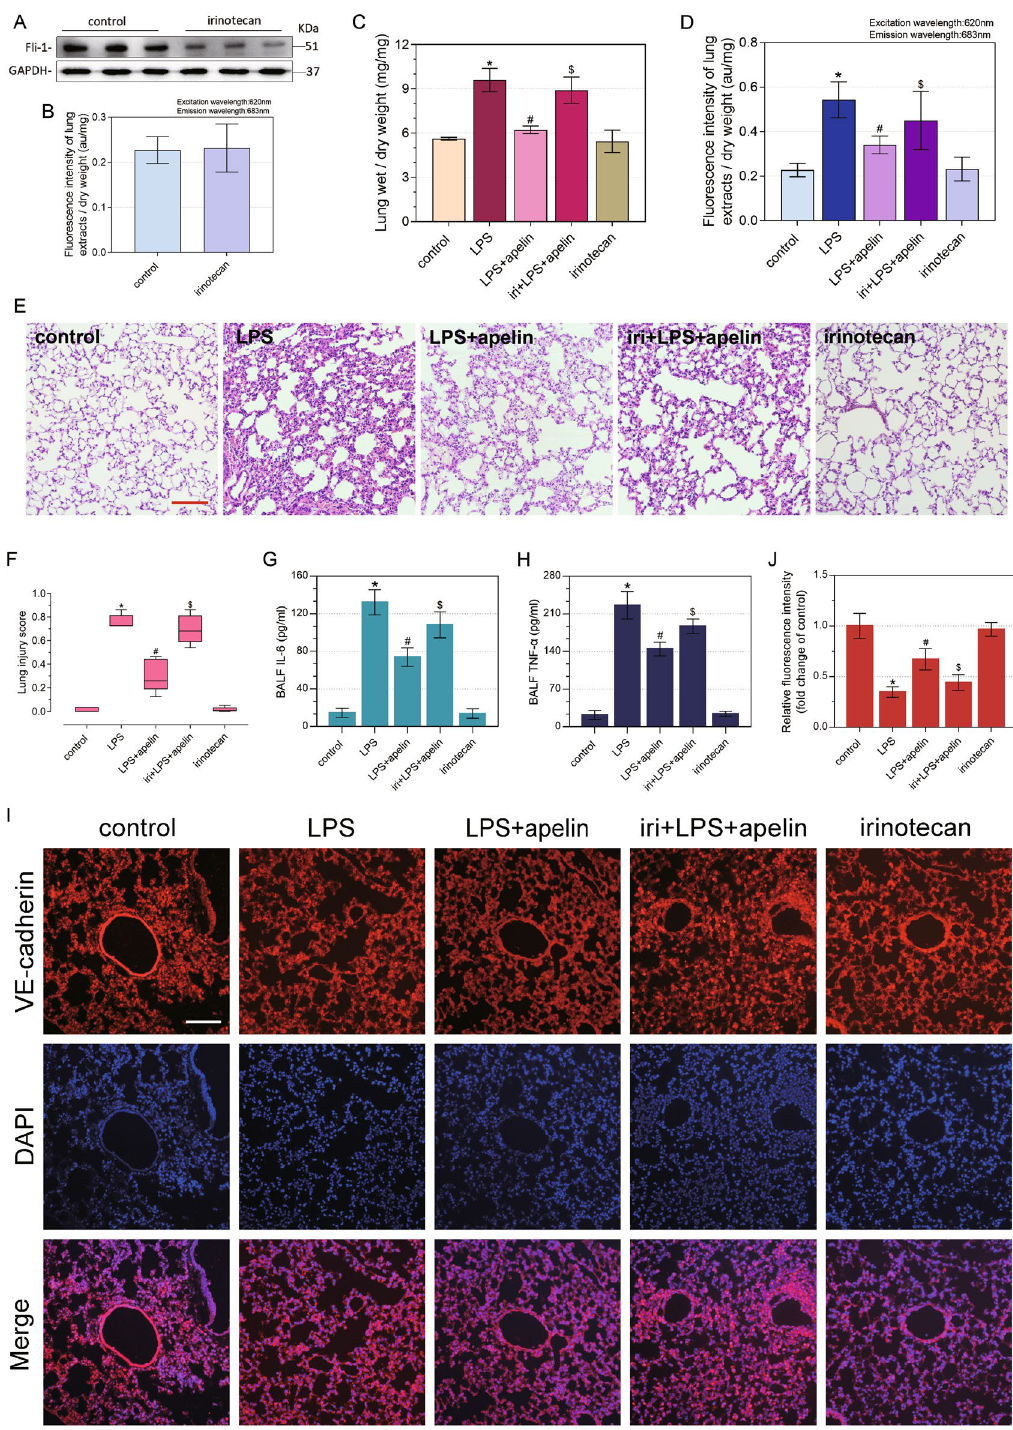
Figure 5. Functional indexes and morphological changes of pulmonary permeability in ALI mice affected by apelin after Fli-1 inhibition. ( A ) Western blot of Fli-1 used to evaluate the inhibitory effect of irinotecan on Fli-1. ( B ) Evans blue assay to evaluate the effect of irinotecan on vascular endothelial permeability. ( C ) Changes in pulmonary vascular endothelial permeability after inhibition of Fli-1, evans blue assay for apelin effect in ALI mice (n = 8). ( D ) Effect of apelin on lung wet/dry weight ratio in ALI mice after inhibition of Fli-1 (n = 4). ( E ) HE staining to observe the inflammatory response of lung tissue treated with apelin in ALI mice, after inhibition of Fli-1 (×200 magnification, scale bar: 100 μm for all images). ( F ) Lung injury score on HE staining (n = 5). ( G ) Levels of inflammatory factor IL-6 in BALF (n = 4). ( H ) Levels of inflammatory factor TNF-α in BALF (n = 4). ( I ) Tissue immunofluorescence staining of VE-cadherin in pulmonary vascular endothelium (×200 magnification, scale bar: 100 μm for all images). Data are presented as the mean ± SEM. *P < 0.05 vs. the control group, # P < 0.05 vs. the LPS group and $ P < 0.05 vs. the LPS + apelin group. ( J ) Relative fluorescence intensity of VE-cadherin in pulmonary vascular endothelium (n =